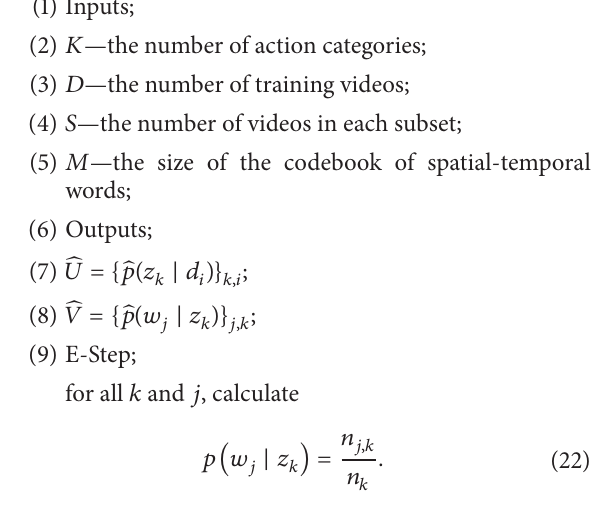
Algorithm 1. Incremental EM Algorithm for PLSA